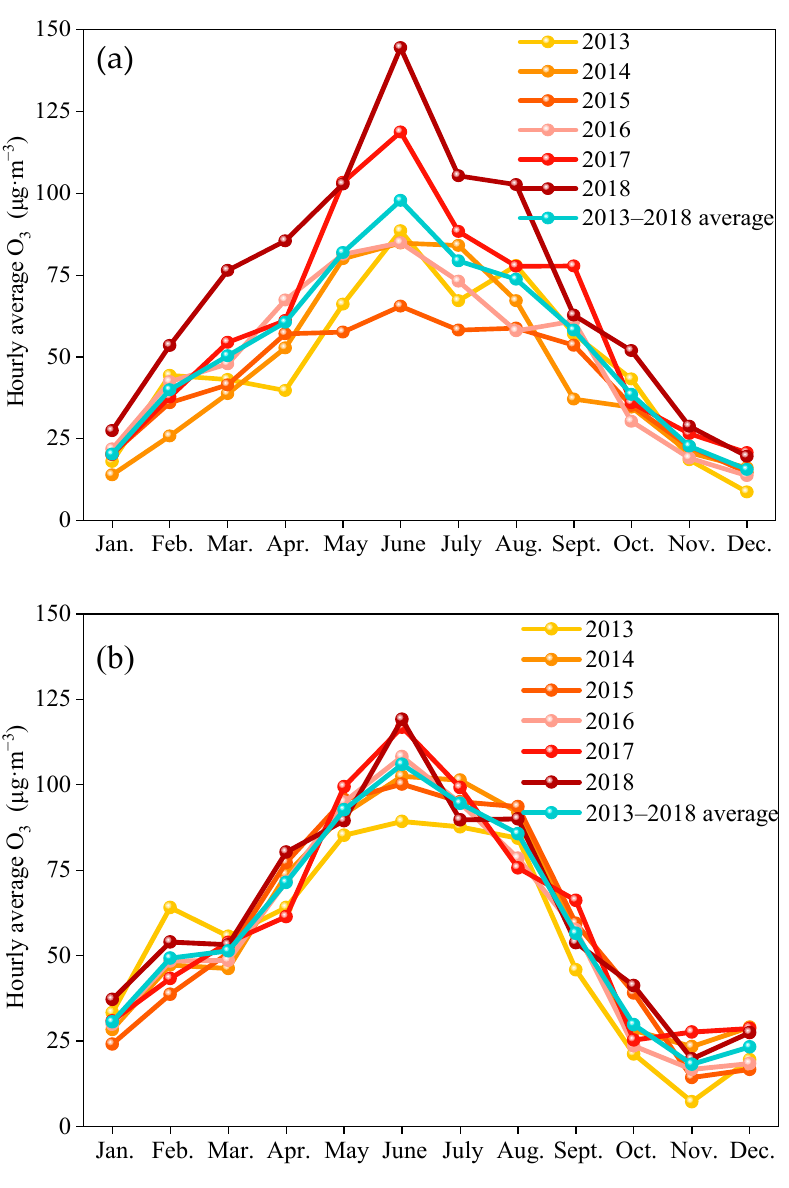
Figure 2. Temporal characteristics of O 3 concentrations in ( a ) downtown Handan and ( b ) downtown Beijing during 2013–2018.